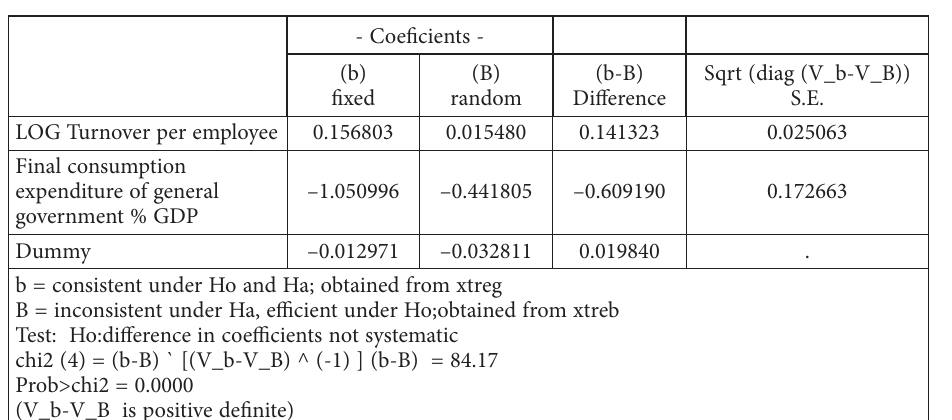
Table 5. Hausman test result (source: authors’ calculations)